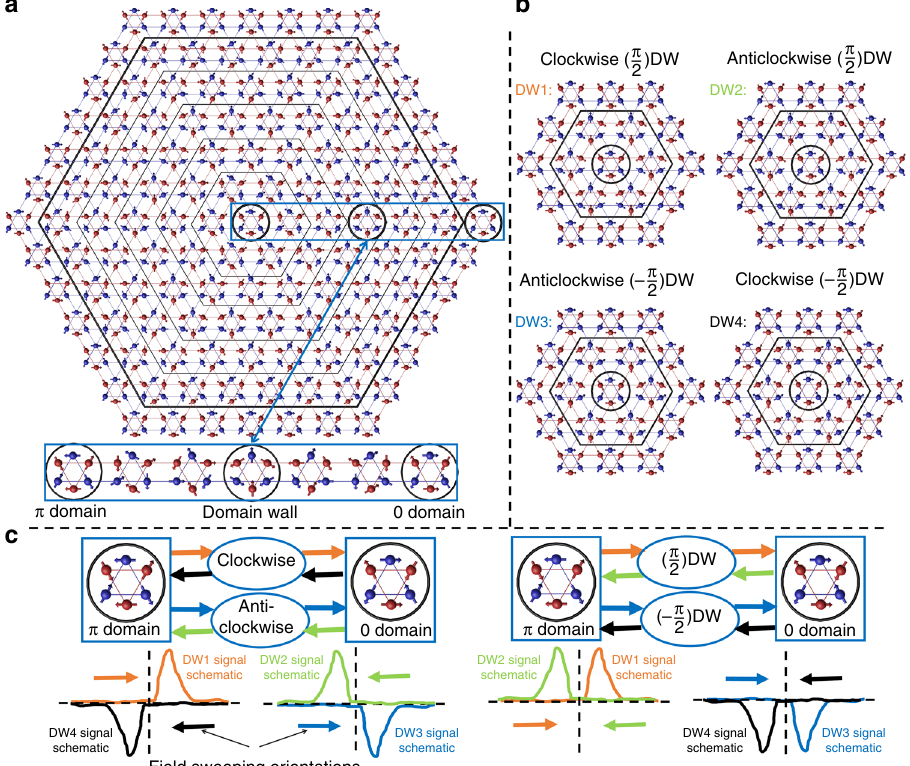
Fig. 3 Spin texture in a domain wall and the signals they generate. a Red and blue circles represent Mn atoms in adjacent planes. Arrows represent spins. A θ = π domain (at the center), a θ = 0 domain (at the periphery) and the wall separating them (in between). For the sake of illustration, the thickness of the wall is assumed to be only fi ve unit cells. Along a radial direction, adjacent equivalent spins tilt by a constant angle. A zoom on the wall along x -axis shows that the domain wall can has a θ = ± π /2 spin con fi guration. b Domain walls can have either + π /2 or − π /2 con fi gurations. This could correspond to a clockwise or an anticlockwise rotation of spins as one moves from the center toward the periphery. c The orientation of the spins at the center of domain wall would explain the fi nite planar Hall effect (PHE) and the transverse magnetization (TM). The sign of these signals (their odd parity or even parity with respect to magnetic fi eld in a hysteresis loop from a θ = π domain to θ = 0 and back) depends on the chirality of the domain wall. The diagrams represent a fi eld sweep (from one domain to another passing by a speci fi c type of domain wall). In each case the four possible sequences are identi fi ed with a colored arrow. In the two plots sketched below each diagram, the same color is used to represent the expected curves for the PHE and TM response. The left-side diagram and plots refer to a case in which rotation keeps the same sense (either clockwise or anticlockwise). As a consequence, the peaks have opposite signs for opposite sweep orientations. The right-side diagram and plots refer to a case in which the orientation of spin remains the same (either + π /2 or − π /2), Therefore, the peaks have the same sign for both sweep